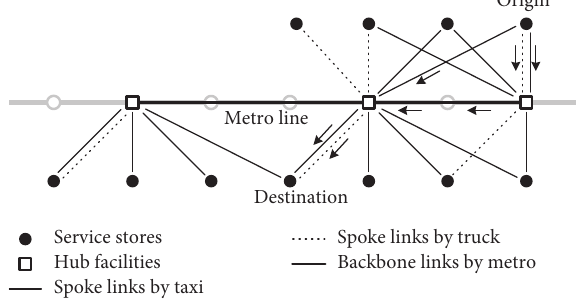
Figure 1: A conceptual multimodal passenger-and-package sharing